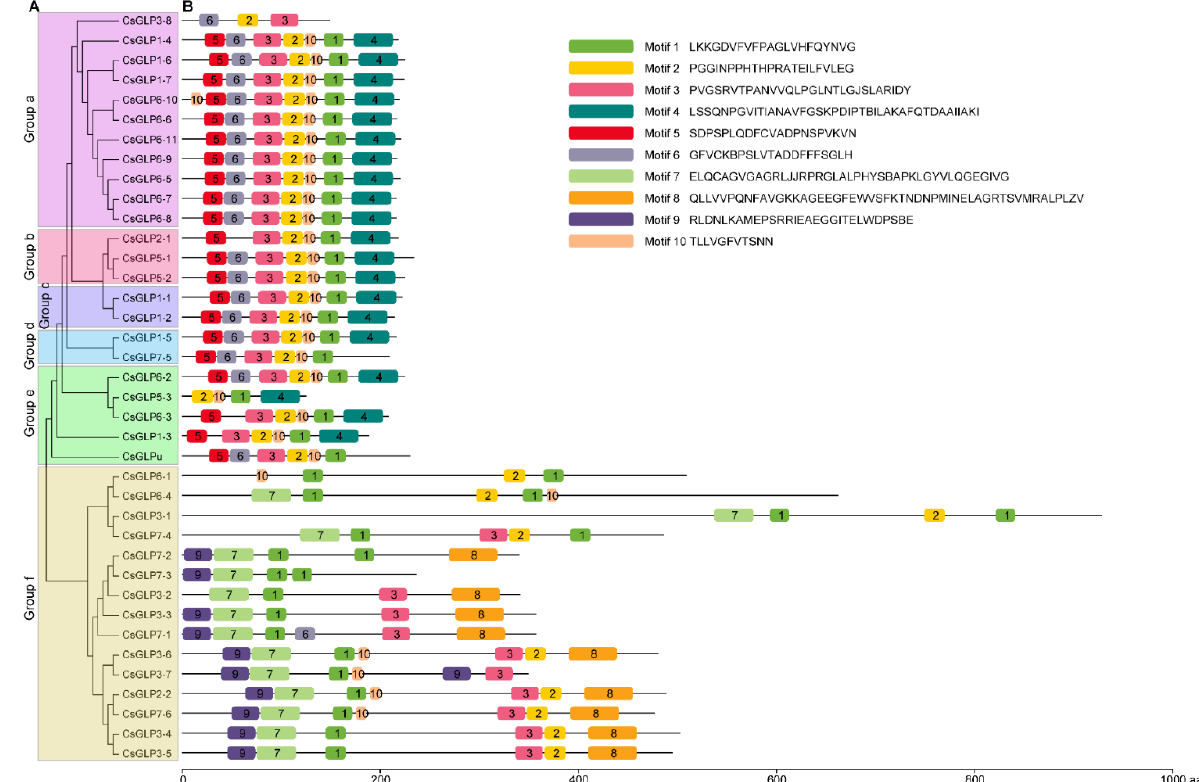
Figure 2. Phylogenetic relationship ( A ) and conserved motif arrangement ( B ) of cucumber GLP family members. ( A ) The phylogenetic tree of CsGLP proteins was created using the NJ method with 1000 bootstrap replicates, and the CsGLP proteins can be divided into six groups (Groups a–f). ( B ) Distribution of 10 conserved motifs among CsGLP proteins identified by MEME, and their amino acid sequences are shown at the right edge.